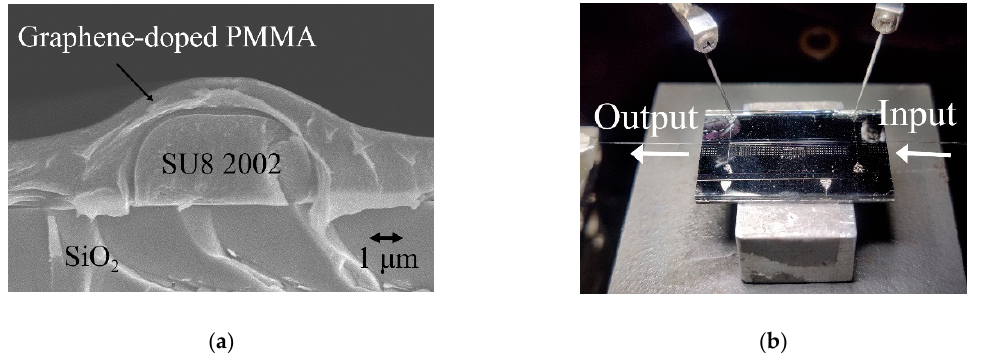
Figure 5. ( a ) The scanning electron microscope image, and ( b ) the photograph of the test system of the graphene-based TO switch.